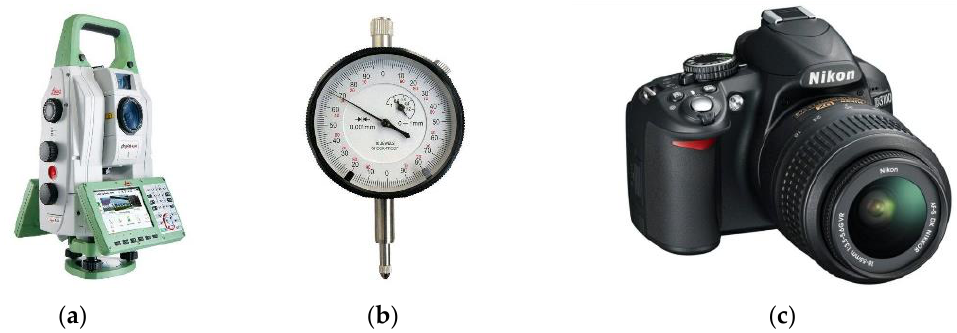
Figure 2. Monitor systems in physical simulation: ( a ) total station, ( b ) dial indicator, and ( c ) camera. Lastly, the data of the experimental process is analyzed and processed. The innovations in this experimental process are using the experimental photos taken by a high-definition camera taken at the same location, using AutoCAD software to sketch the experimental process.